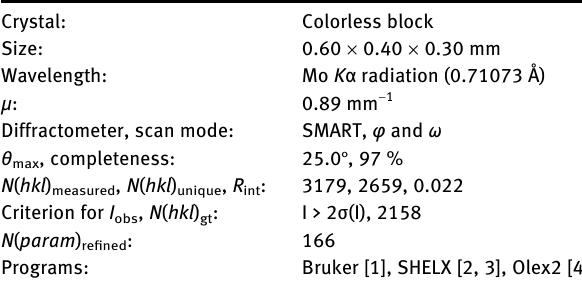
Table  : Data collection and handling. Crystal: